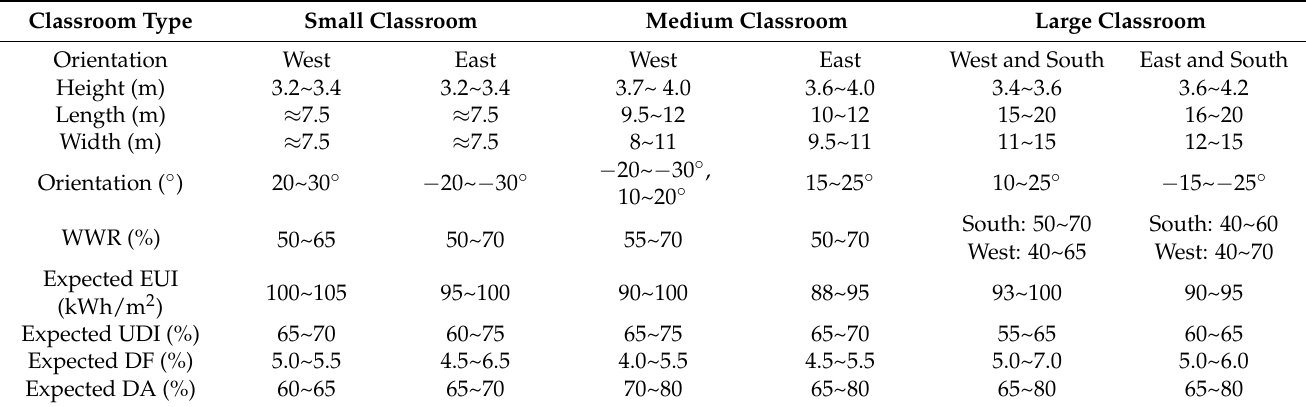
Table 19. All possible ranges of optimization results for rectangular